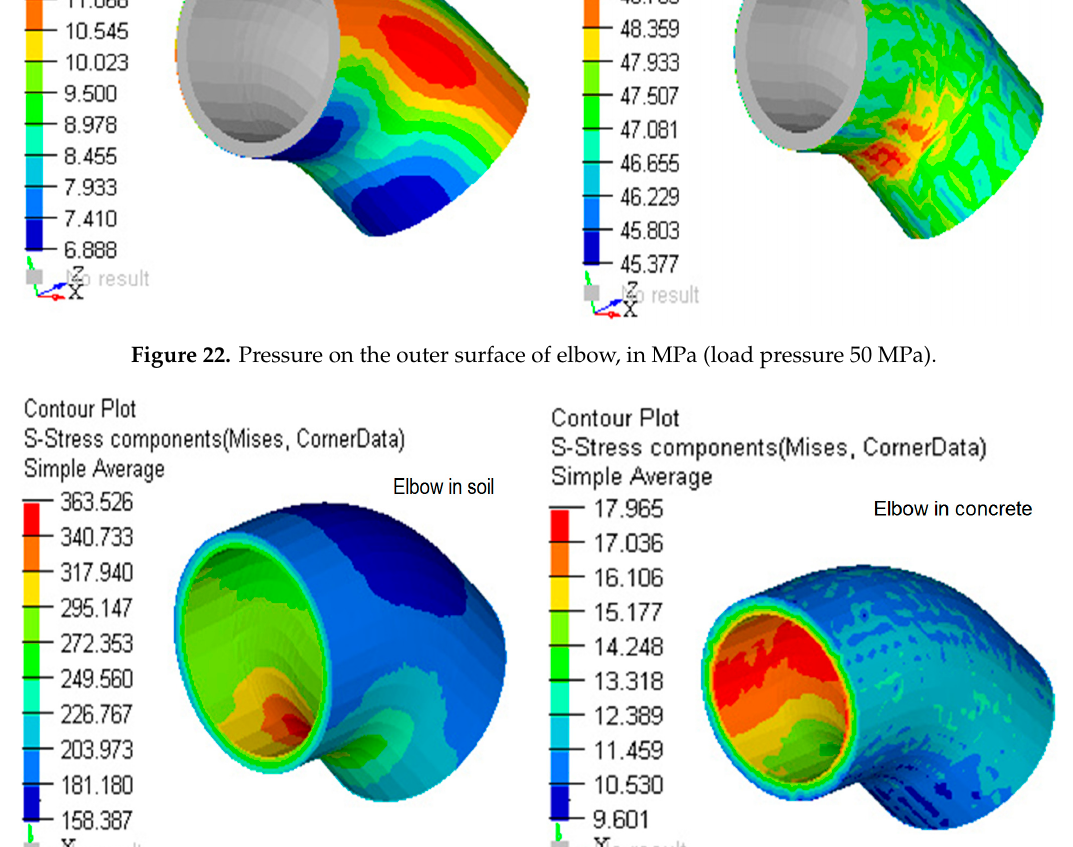
Figure 23. Stresses von Mises in elbow, in MPa (load pressure 50 MPa).